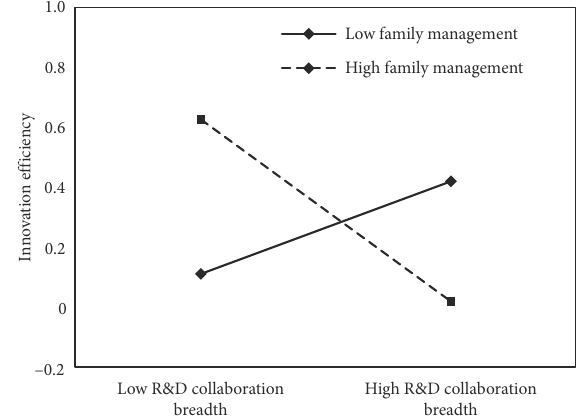
Figure 2. Moderating influence of family management on the R&D collaboration breadth-innovation